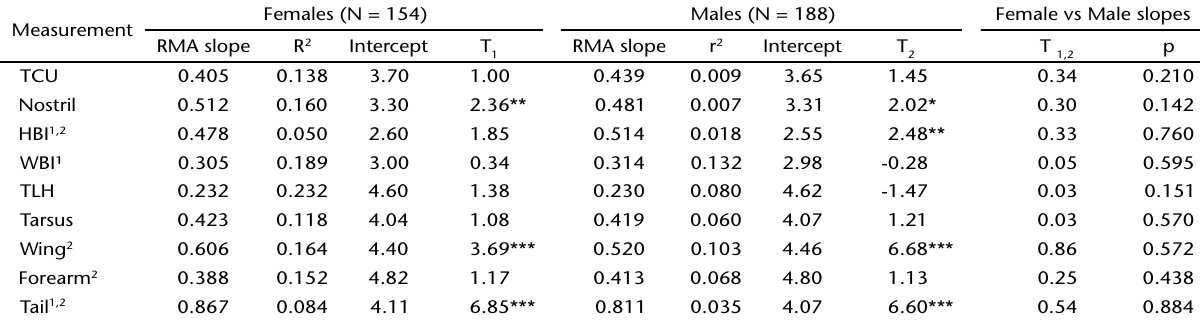
Table II. Scaling of mature Coscoroba Swan morphometric measurements against body mass using Reduced Major Axis (RMA) regression. The deviation of the RMA slope from that expected under isometry (1/3) was tested for statistical significance for each measurement and sex (T , T ) as well as slope difference between sexes (T 1 2